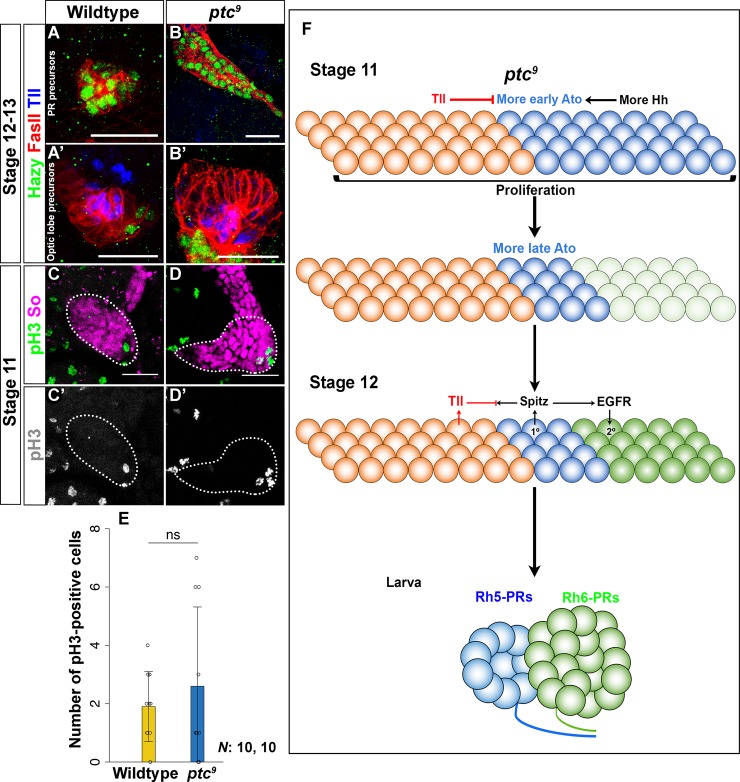
Hh signaling controls cell number in the optic placode.Tll (blue) expression in wildtype and ptc9 mutants (stage 12–13 embryos). Hazy (green) marks all PR precursors whereas FasII (red) labels larval eye and optic lobe primordium. (A, B) In the larval eye precursors, Tll is neither expressed in wildtype (A) nor in ptc9 mutants (B). Tll is expressed in the optic lobe precursors in wildtype (A’) and its expression is unchanged in ptc9 mutant embryos (B’). (C, C’, D, D’, E) Analysis of cell proliferation at stage 11 in the optic placode in wildtype and ptc9 mutant embryos by staining with anti-pH3 (green) antibody. So (red) was used to mark the area of the optic placode, from where pH3-positive cells were counted (white outline in C and D). The number of pH3-positive cells in the Eya-positive domain of ptc9 mutants is not significantly different from that of wildtype p = 0.4655, t(18) = -0.7457 (E). n = 10 (wildtype), 10 (ptc9) (E). Data is shown as mean and error bars as standard deviation. Circles represent numbers of individual samples. ns = not significant (E). (F) Schematic representation of Hh mediated optic placode patterning and acquisition of PR versus non-PR cell fate in the embryo. Hh signaling promotes Ato expression and Hh gain-of-function (in ptc9 mutants) show an increased number of Ato expressing cells in the optic placode [6]. Scale bars represent 20 μm.